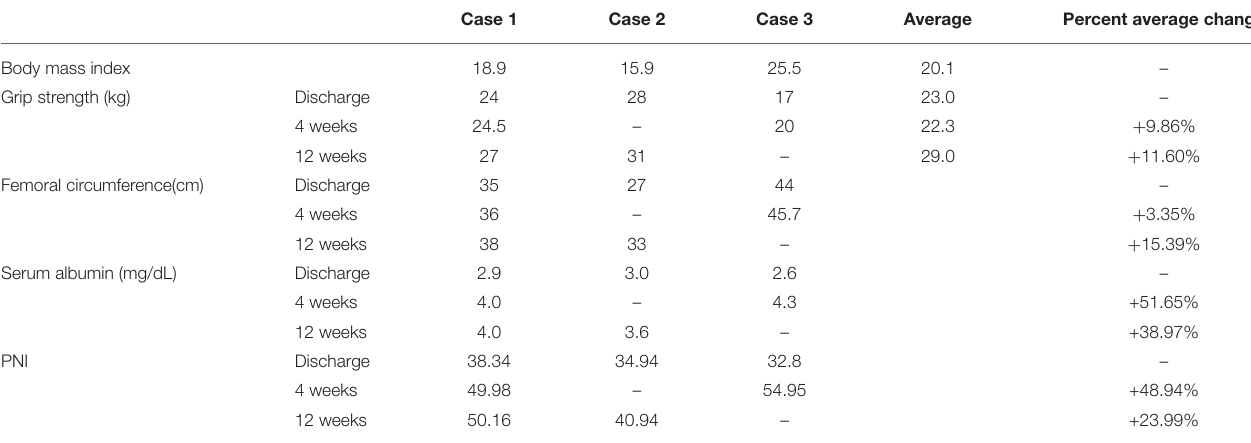
TABLE 2 | PNI in our 3 elderly patients taking ninjin’yoeito after discharge.